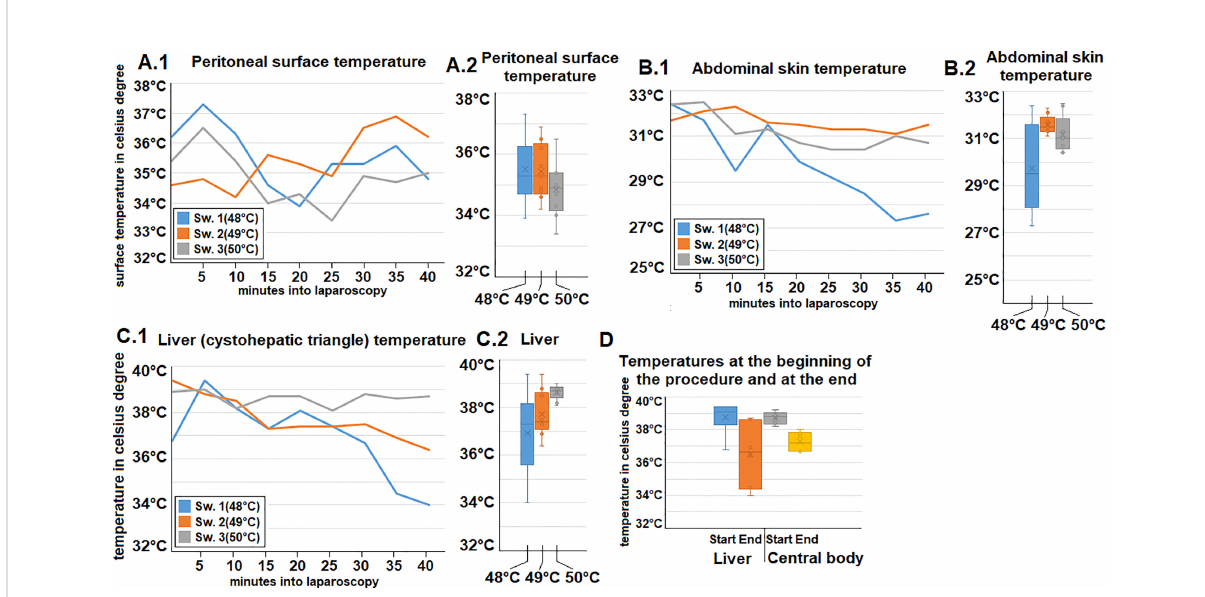
FIGURE 3 Intraoperative temperature measurements during gas-based i.p. hyperthermia at distinct sites presented for each swine (A.1, 2) at the peritoneal surface (B1, 2) Abdominal skin, (C1, 2) temperature of the “ liver ” (cystohepatic triangle). (D) Measured temperatures at the beginning and end of gas-based i.p. hyperthermia in all swine of the “ liver ” (cystohepatic triangle) and core body temperature (measured in the oesephageal